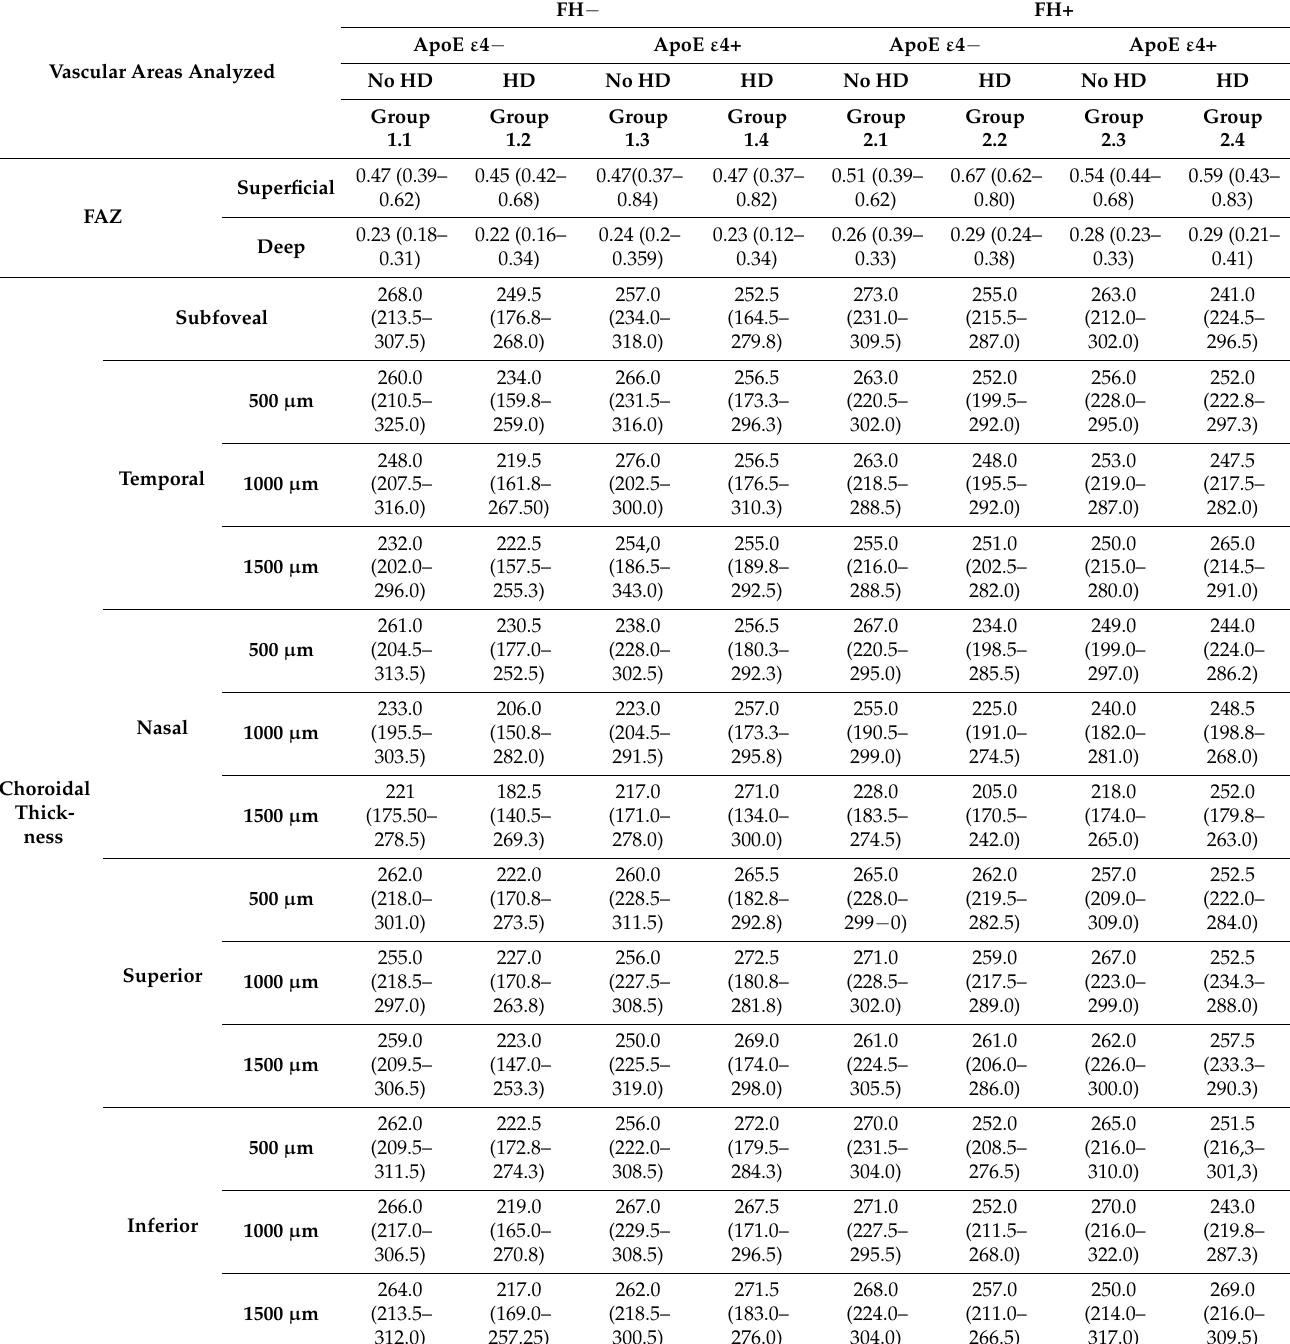
Table 3. Median and interquartile range of the FAZ and choroidal thickness in the study